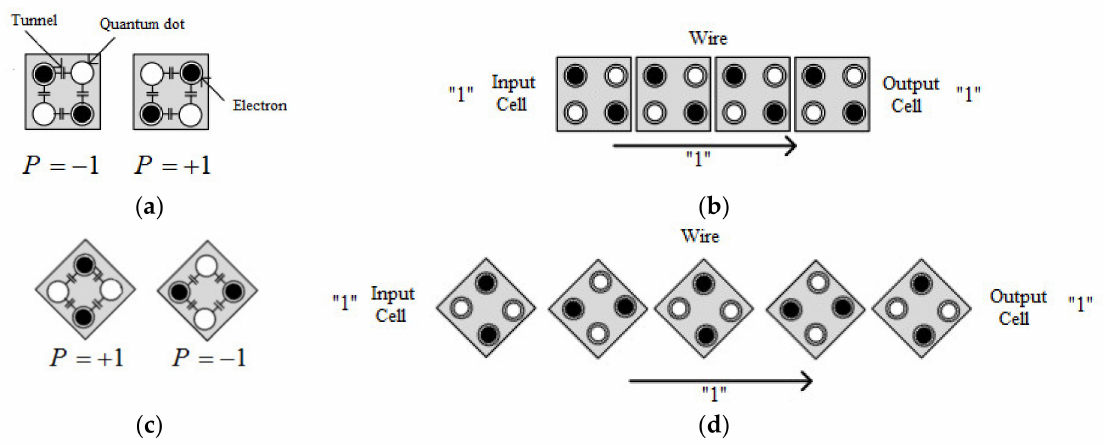
Figure 1. Schematics types of QCA cells ( a ) two structures logical values the QCA 90-degree cells, ( b ) QCA 90-degree wire, ( c ) two structures logical values the QCA 45-degree cells, ( d ) QCA 45-degree